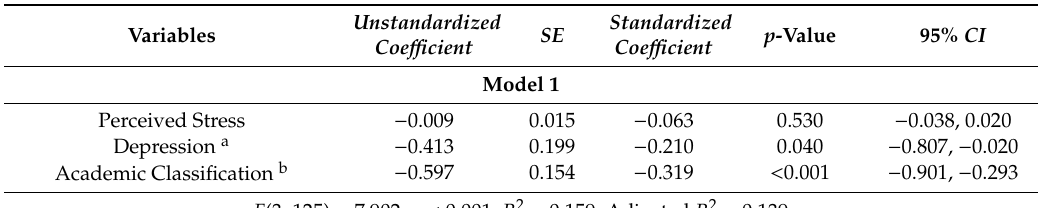
Table 3. Hierarchical Multiple Regression Predicting Initiation for Intentional Relaxation Behavior ( N =